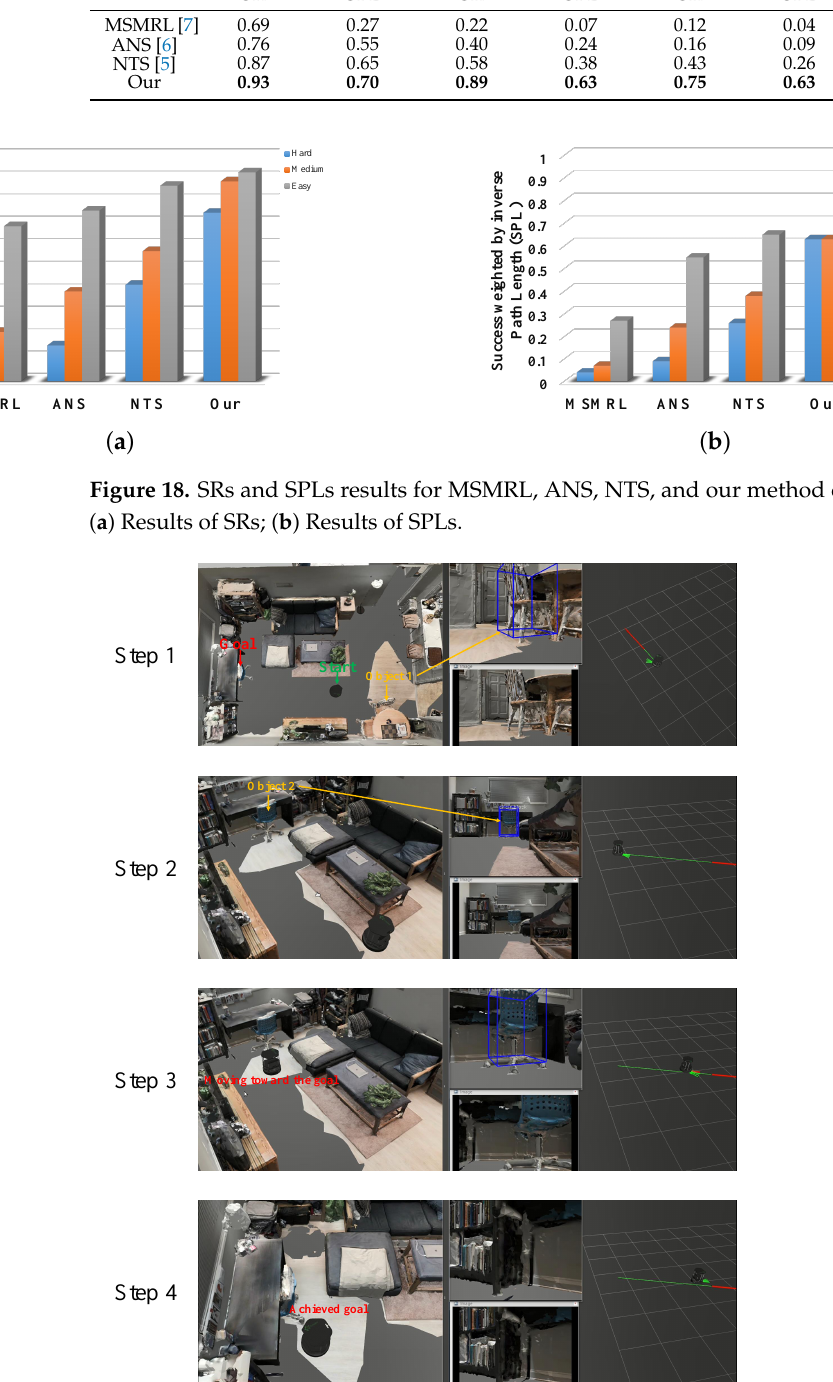
Figure 19. Visualization results for navigation in simulation scenario. The first step acquires global topological paths through active visual perception and object guidance, and generates segmented smooth trajectories. The second step determines the goal position by goal object evaluation and it generates segmented smooth trajectories. The third step moves toward the target location. The fourth step moves to within 1 meter of the goal object and publishes an "arrived" command to end the